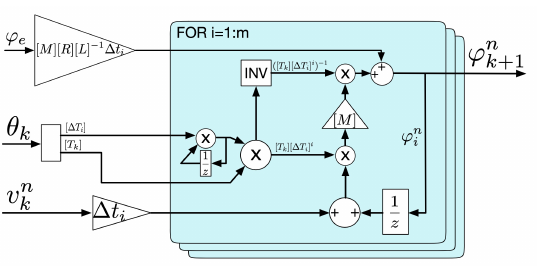
Figure A2. Discrete time model with fast matrix inversion and PM flux: